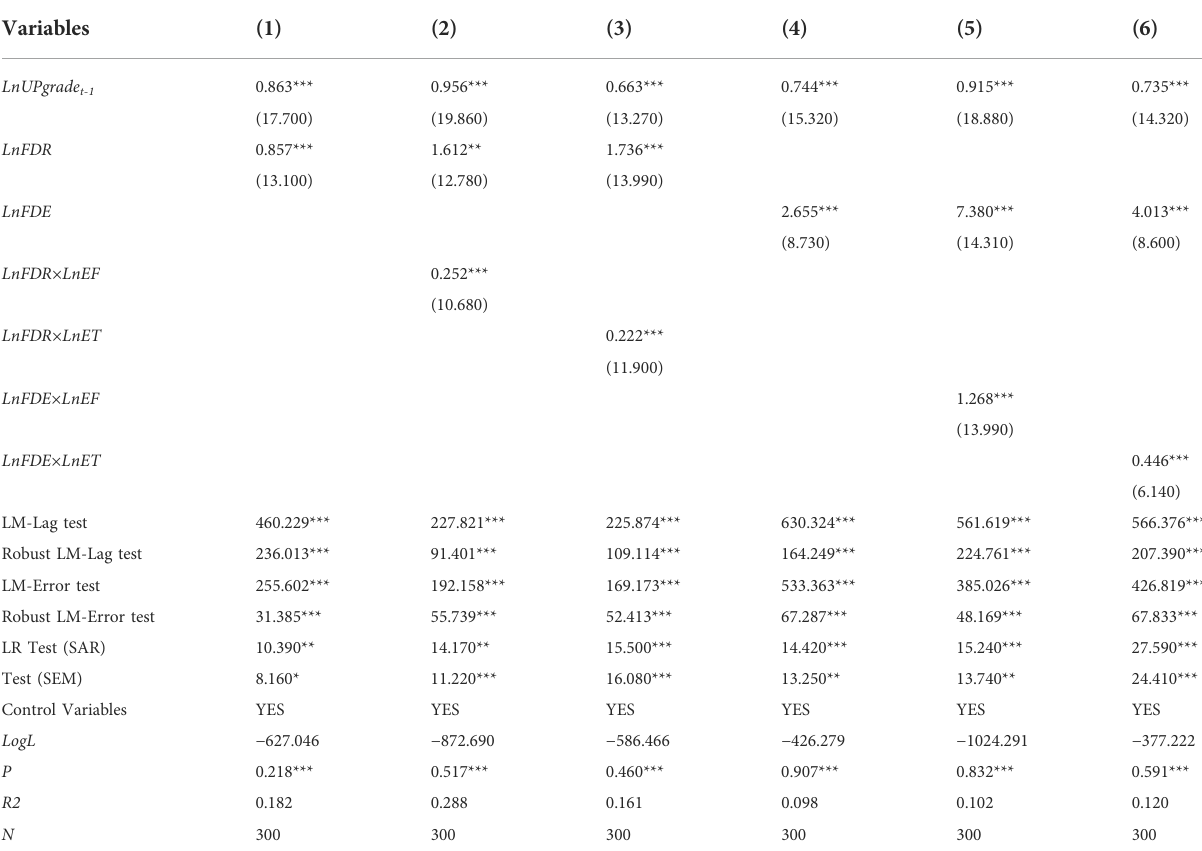
TABLE 10 Estimated results of heterogeneity analysis of fi scal